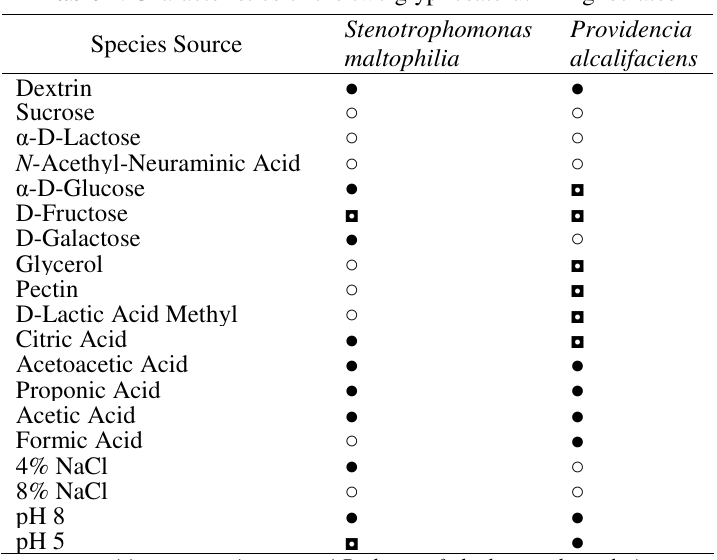
Stenotrophomonas Providencia maltophilia